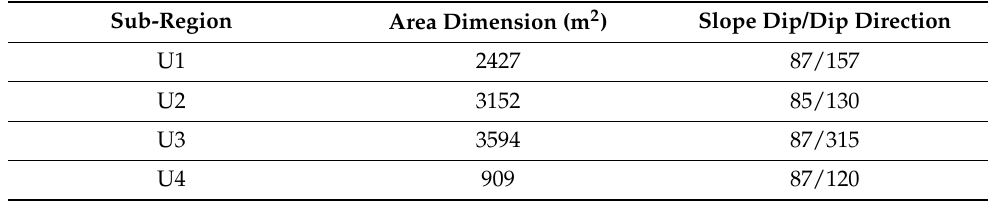
Table 1. Main characteristics of the sub-regions that the initial point cloud was segmented